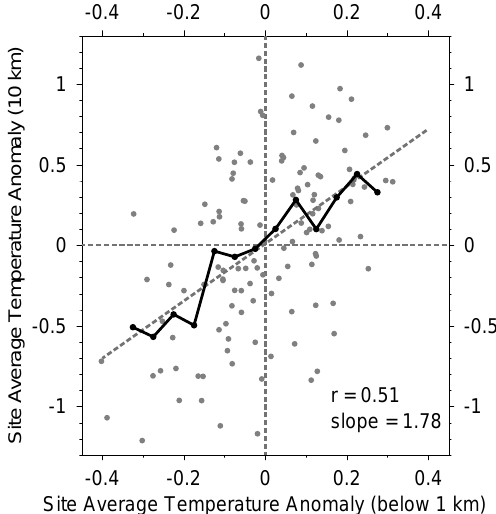
Fig. 5. The gray dots are a scatterplot of the monthly mean 10 km temperature anomaly versus the monthly mean surface temperature anomaly (below 1 km ). Each dot represents an average over all radiosonde stations in which the monthly mean rainfall rate exceeded 3 mm per day. The dashed line shows a best fit regression. The solid line shows the mean 10 km temperature anomaly calculated from grouping the surface temperature anomalies in bin sizes of 0.05 K.